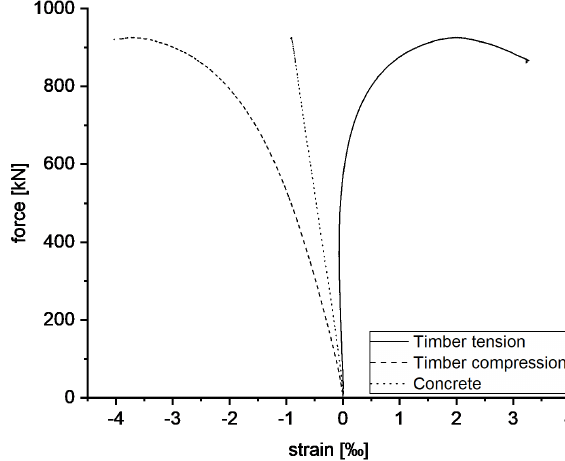
Figure 10. Development of strains at the vertical wall centre for timber and concrete for experiment V_D_30_10_1. [5].